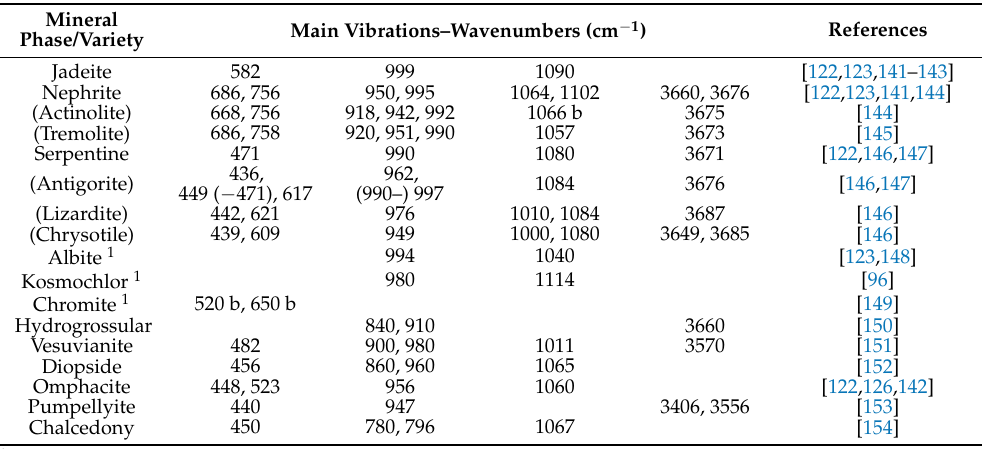
Table 5. Infrared main vibrational absorption bands of Green Stones. The IR main bands of the pure actinolite and tremolite phases, along with nephrite, antigorite, lizardite, and chrysotile phases, along with serpentine, have been reported as references for completeness.